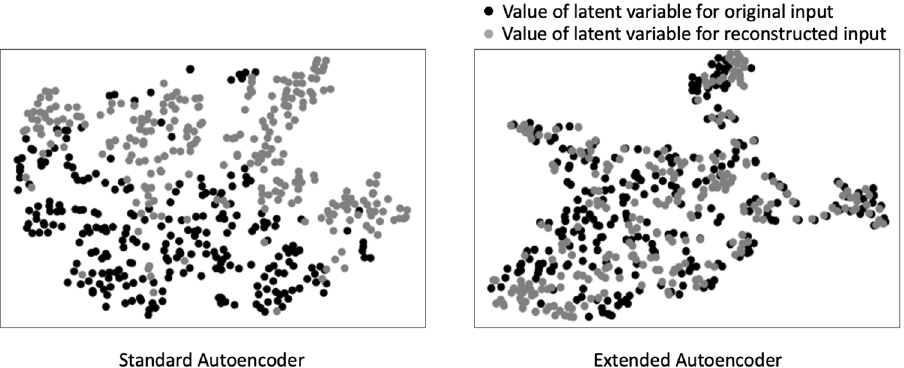
Figure 2. t-SNE (Stochastic Neighbor Embedding) visualization of the values of latent variables in the standard autoencoder (left) and the extended autoencoder (right) with normal samples. The digit 8 in MNIST (Modified National Institute of Standards and Technology) dataset is fed as a normal data to train the autoencoders. The values of latent variables for original input data and reconstructed ones are represented as black and gray points, respectively.